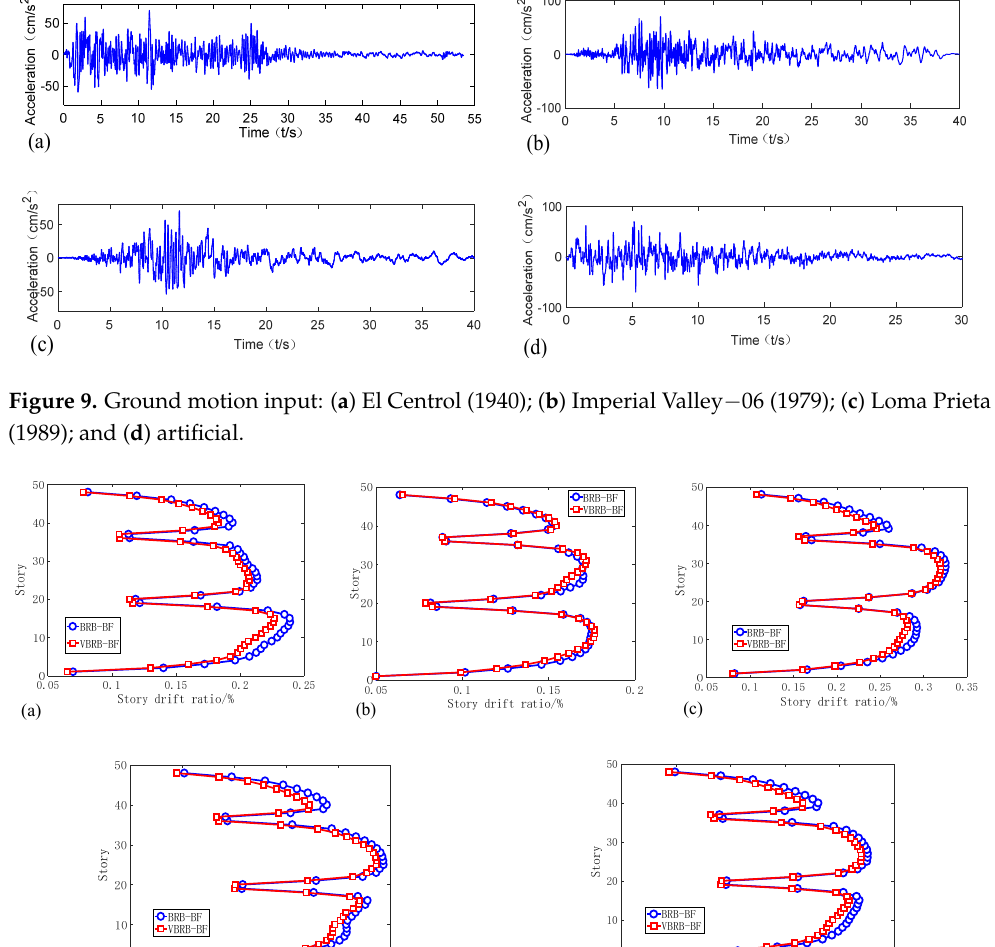
Figure 9. Ground motion input: ( a ) El Centrol (1940); ( b ) Imperial Valley − 06 (1979); ( c ) Loma Prieta (1989); and ( d ) artificial.